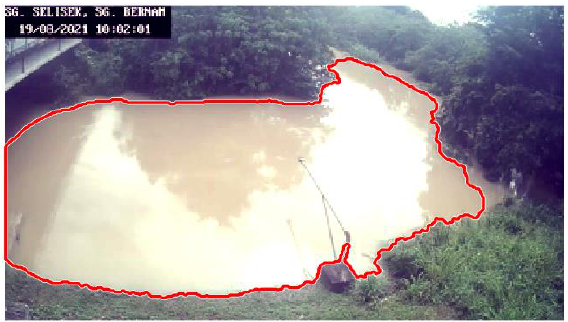
Figure 3 . The segmentation result that extracts water from the